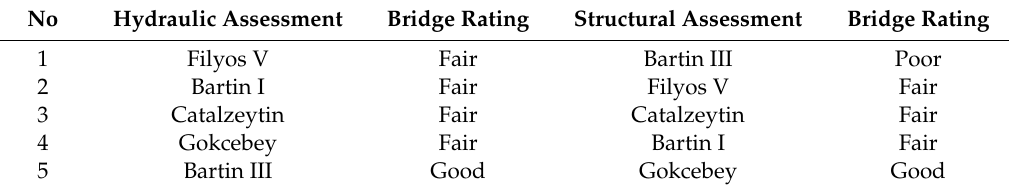
Table 16. Prioritization of river bridges according to inspection grades.